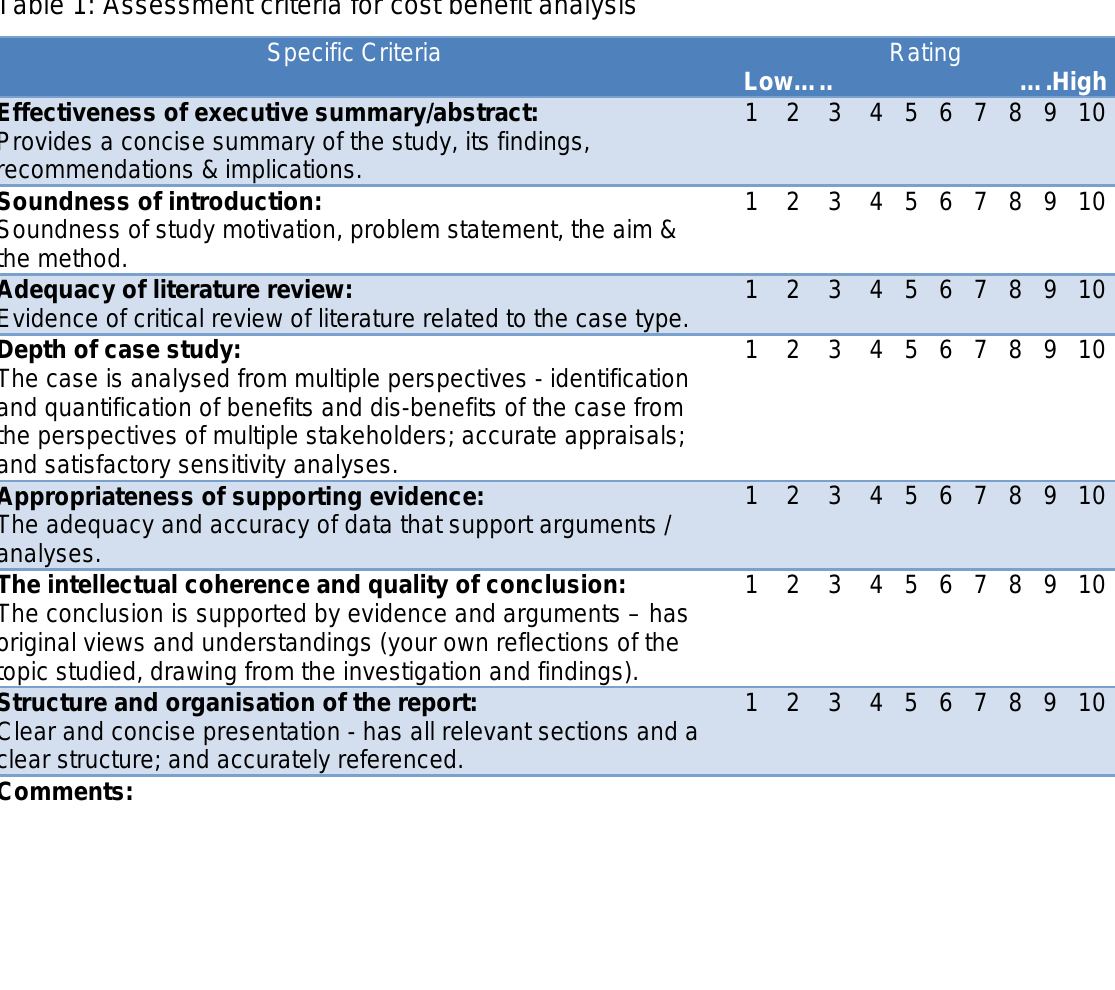
Table 1: Assessment criteria for cost benefit analysis Specific Criteria Rating Low…..